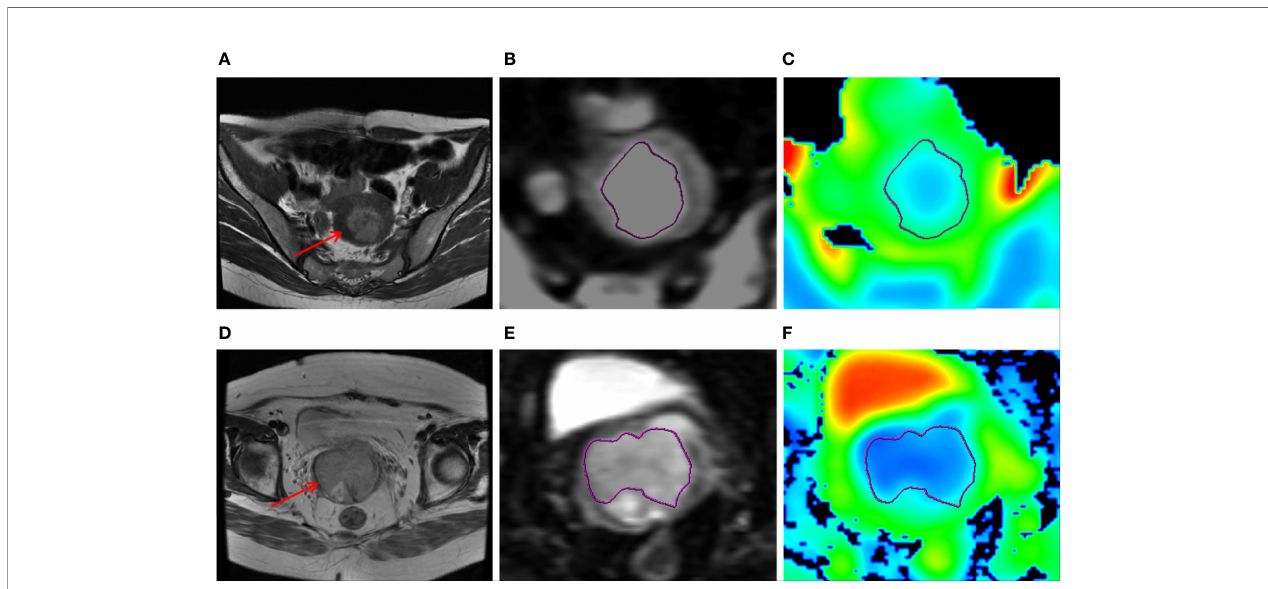
FIGURE 2 | (A – C) MR images of a 47-year-old woman with grade 1 endometrioid carcinoma, pathologically proven DMI and absence of LVSI or LNM. (A) Axial T2- weighted image showed that there was an irregular mass in the uterine cavity (arrow), the tumor size 3.5 cm × 3.5 cm. (B) ROI at the maximum area of the lesion on DWI. (C) The ADC map. (D – F) MR images of a 47-year-old woman with grade 1 endometrioid carcinoma, pathologically proven DMI, and LVSI but absence of LNM. (D) Axial T2-weighted image showed that there was an irregular mass in the uterine cavity (arrow), the tumor size 3.5 cm × 4 cm. (E) ROI at the maximum area of the lesion on DWI. (F) The ADC